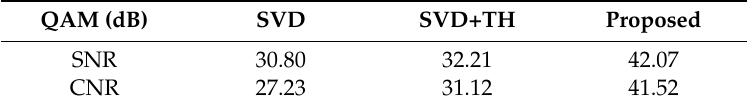
Table 1. Quantitative assessment measures (QAM) calculation for flow phantom.